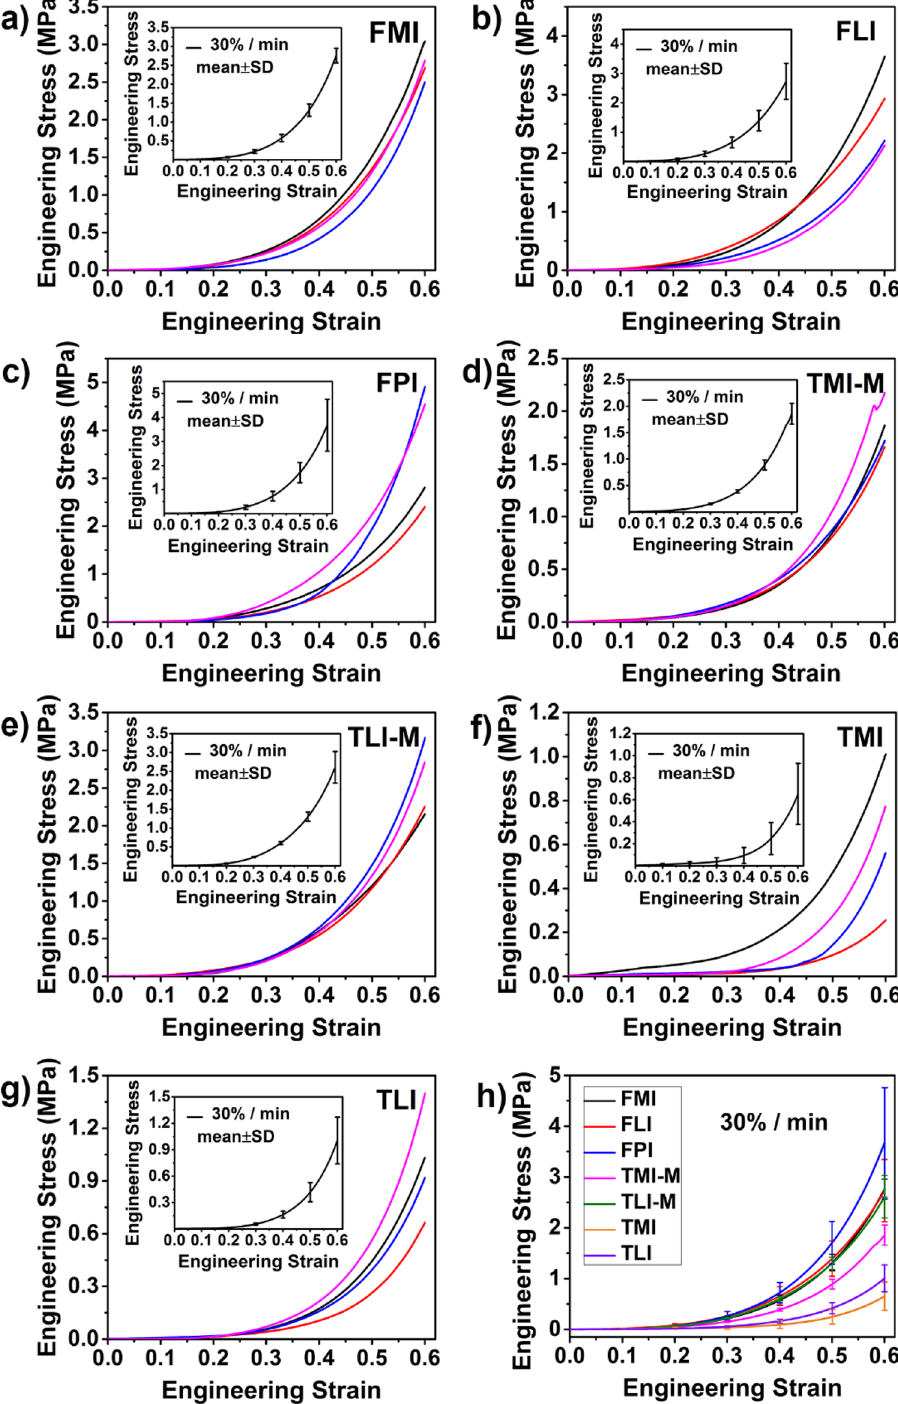
Figure 3. ( a – g ) Stress–strain curves of cartilage in predetermined regions at strain rate 30%/min. Inset: mean of four repetitions with error bar (± SD). ( h ) The comparison of mean stress–strain curves for seven regions at strain rate